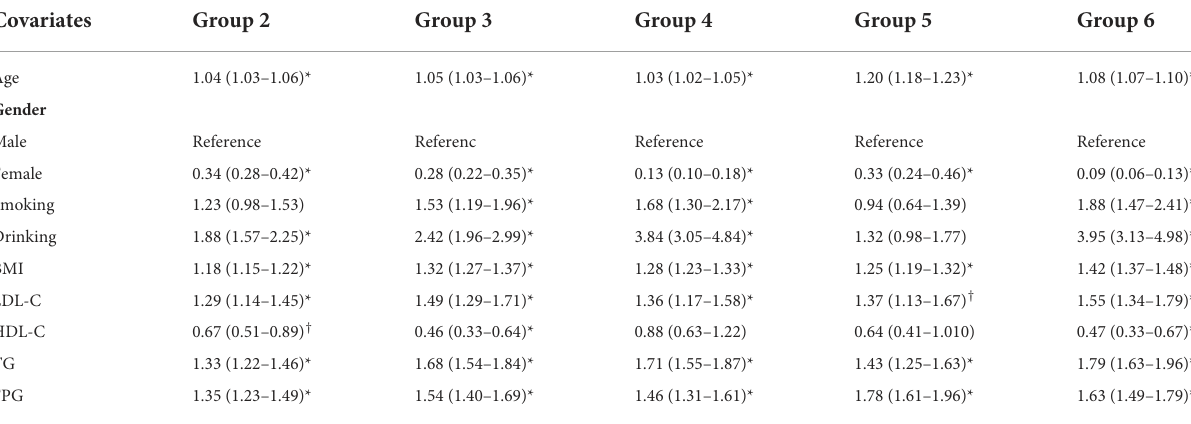
TABLE 4 ORs and 95% CIs of single covariates on multi-trajectories with trajectory group 1 as reference. Covariates